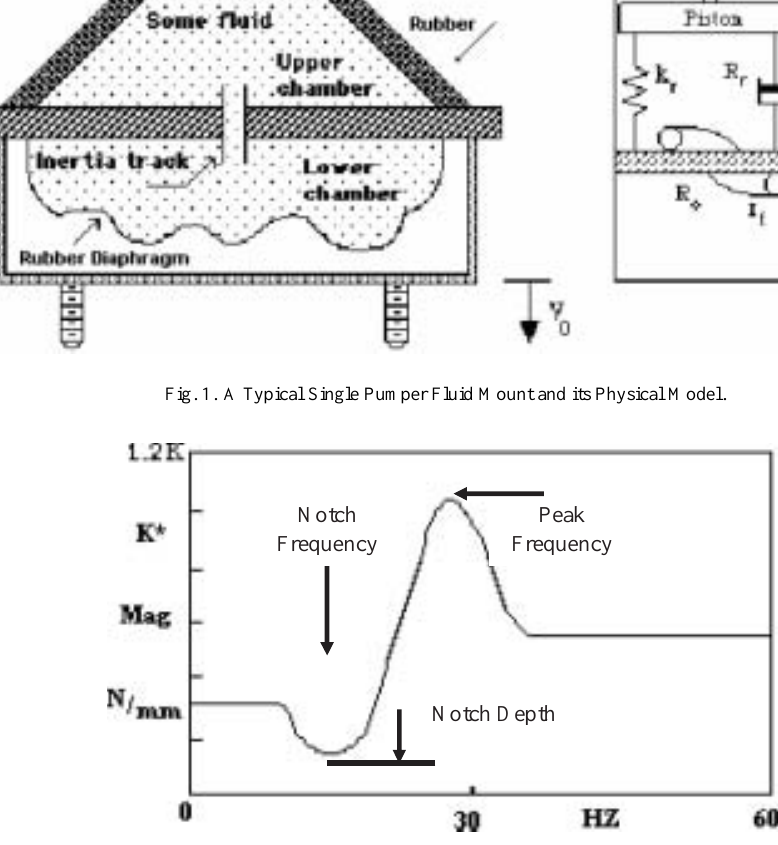
Fig. 2. Dynamic Stiffness of a Typical Fluid Mount versus